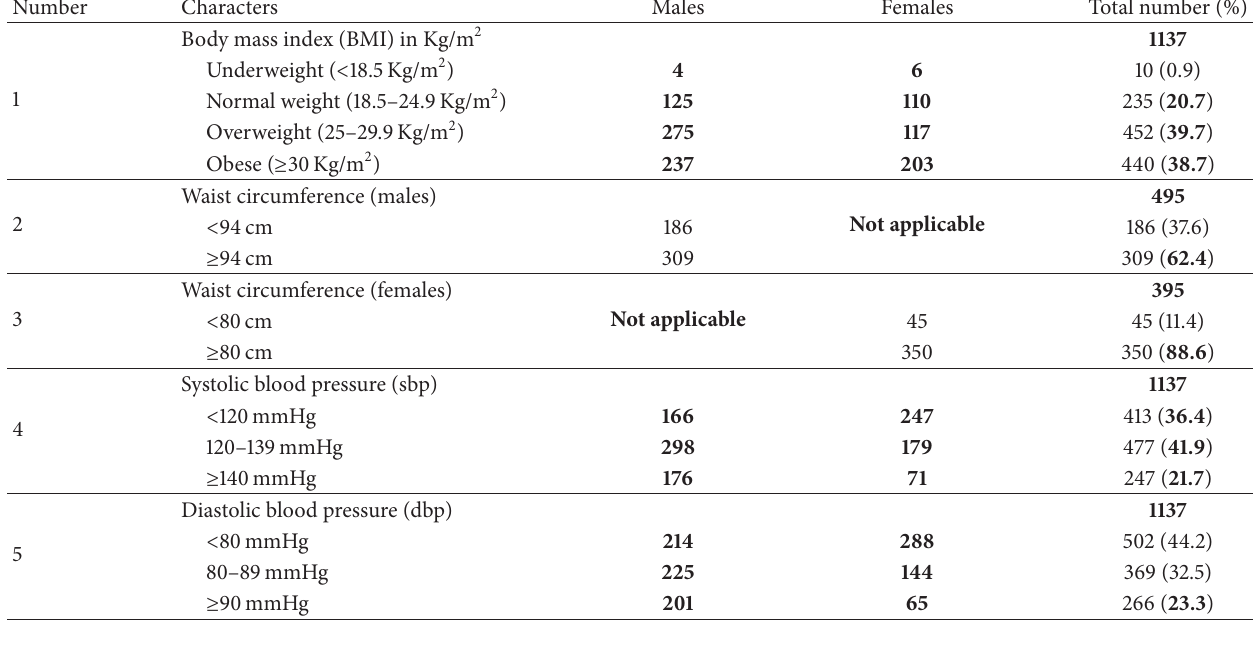
Table 2: The physical measurements of the participants (employees).